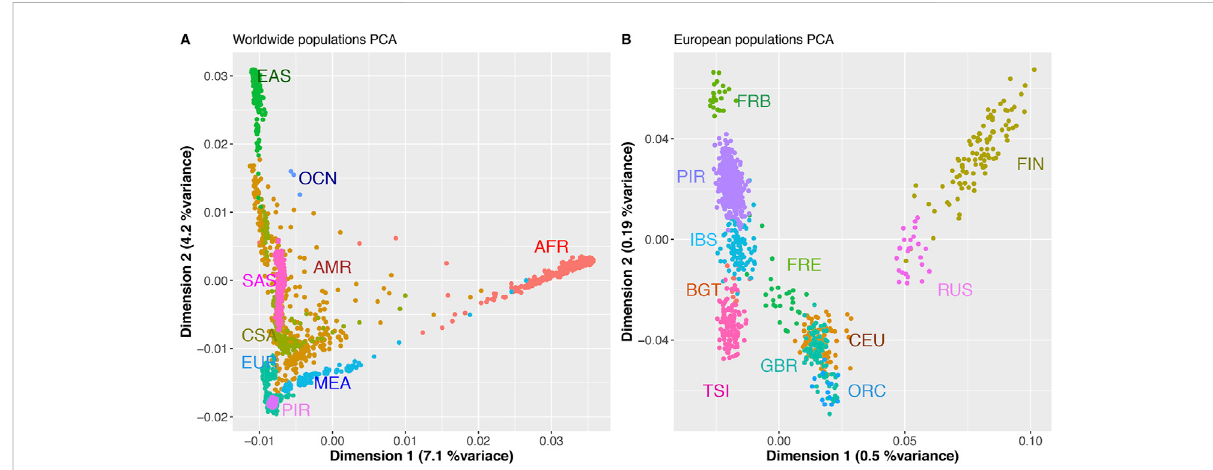
FIGURE 2 First twoPCs of PCAanalysesofworldwide populations (A) , and European populations (B) including theGENPIR population. (A) PCA analysis of world-wide superpopulations, African (AFR, n = 736); Amerindians (AMR, n = 372); Central Asia (CSA, n = 194); Europeans (EUR, n = 651); East Asia (EAS, n = 715); Middle east (MED, n = 161); South Asia (SAS, n = 475); Oceania (OCN, n = 20) and catalan Pyrenean (PIR, n = 397) samples. (B) PCA analysisofEuropeanpopulations,Finland(FIN, n =99),Russia(RUS, n =25);GreatBritainandScotland(GBR, n =89);Orcadian(Scotland)(ORC, n = 14); Utah residents (CEPH) with Northern and Western European ancestry (CEU, n = 95); French Basques (FRB, n = 23); France (FRE, n = 28); Iberian Peninsula (Spain) (IBS, n = 107); Bergamo (Italy) (BGT, n = 12) and Toscana (Italy) (TSI, n =